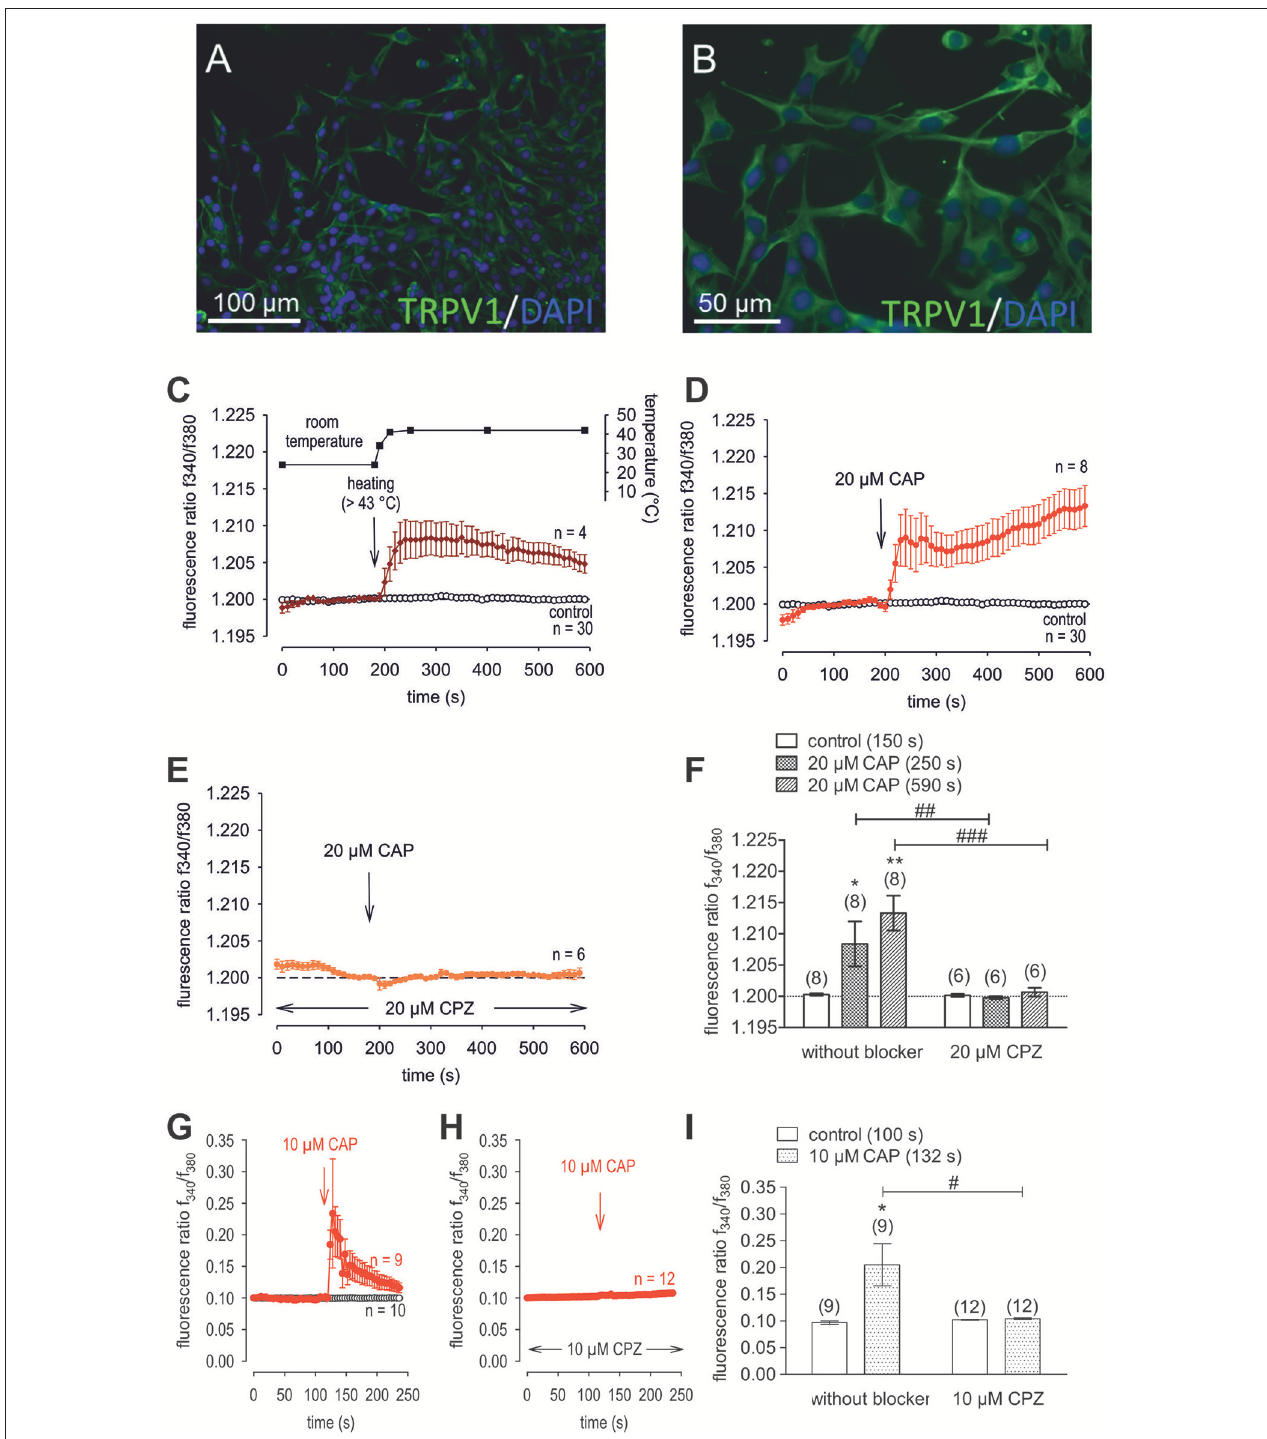
FIGURE 4 | Confirmation of protein and functional TRPV1 expression in cultivated human corneal keratocytes (HCK). (A,B) Localization of TRPV1 in SV40-immortalized human corneal keratocytes (HCK). IF analysis reveal subcellular TRPV1 expression (green) in all HCK cells. Cell nuclei were counterstained with DAPI (blue) and pictures were merged. Pictures are representative of IF results from different cell passages. (C) Temperature increase from ≈ 23 ◦ C to > 43 ◦ C increased [Ca 2 + ] i ( n = 4). The corresponding temperature time course is shown above the Ca 2 + traces. The thermal and pharmacological changes were carried out at the time points indicated by arrows. (D) CAP (20 µ M) induced an irreversible increase in Ca 2 + influx ( n = 8) whereas non-treated control cells maintained a constant Ca 2 + baseline ( n = 30). (E) Same experiment as shown in (D) , but in the presence of capsazepine (CPZ). CPZ (20 µ M) suppressed the CAP-induced Ca 2 + increase